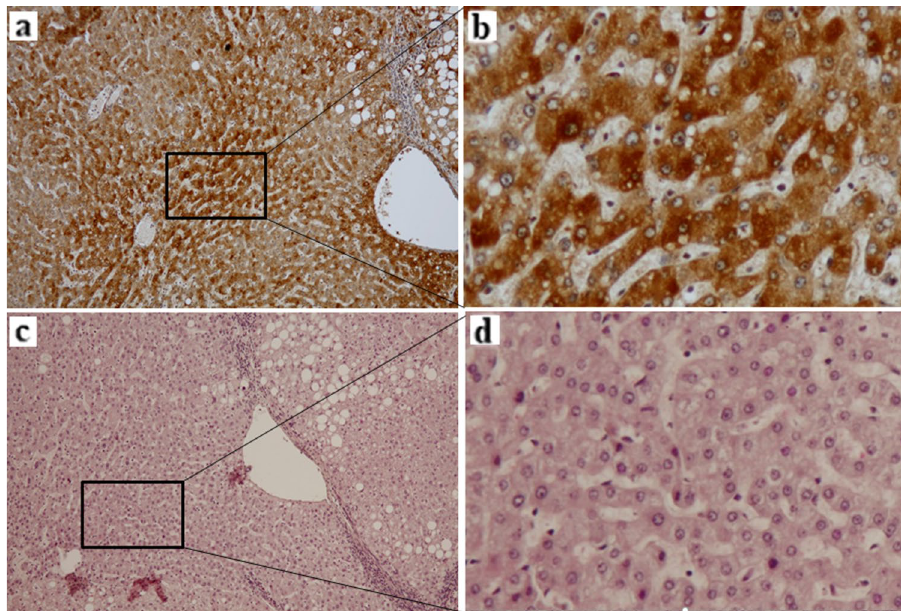
Figure 4. Immunohistochemistry revealed that CDT1-positive cells corresponded to atypical hepatocytes. ( a ) Image show lower magnification of CDT1 staining. (Counterstained by hematoxylin, × 100). ( b ) The area circled by the square indicates CDT1-positive cell aggregation. (Counterstained by hematoxylin, × 400). ( c ) Image of HE staining shows almost the same section as the CDT1-staining image of ( a ) (HE, × 100). ( d ) The area circled by the square indicates atypical hepatocytes aggregation (HE, × 400).